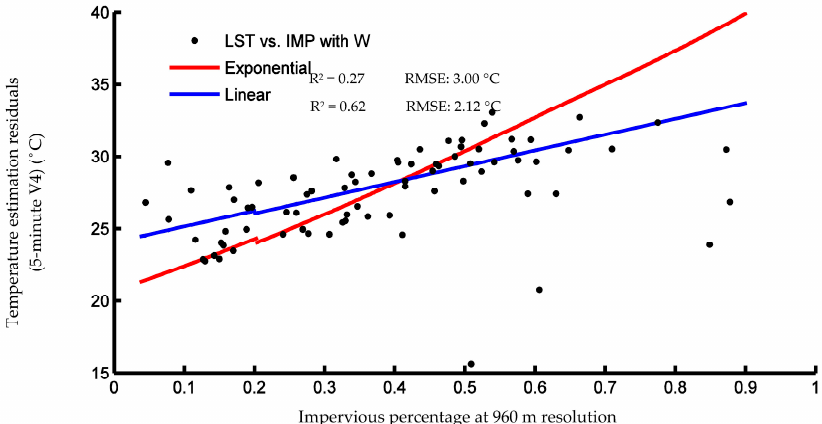
Figure 5. Linear (blue line) and an exponential (red line) fit for MODIS/Terra land surface temperature product (V4) with 100% of impervious percentage pixels.